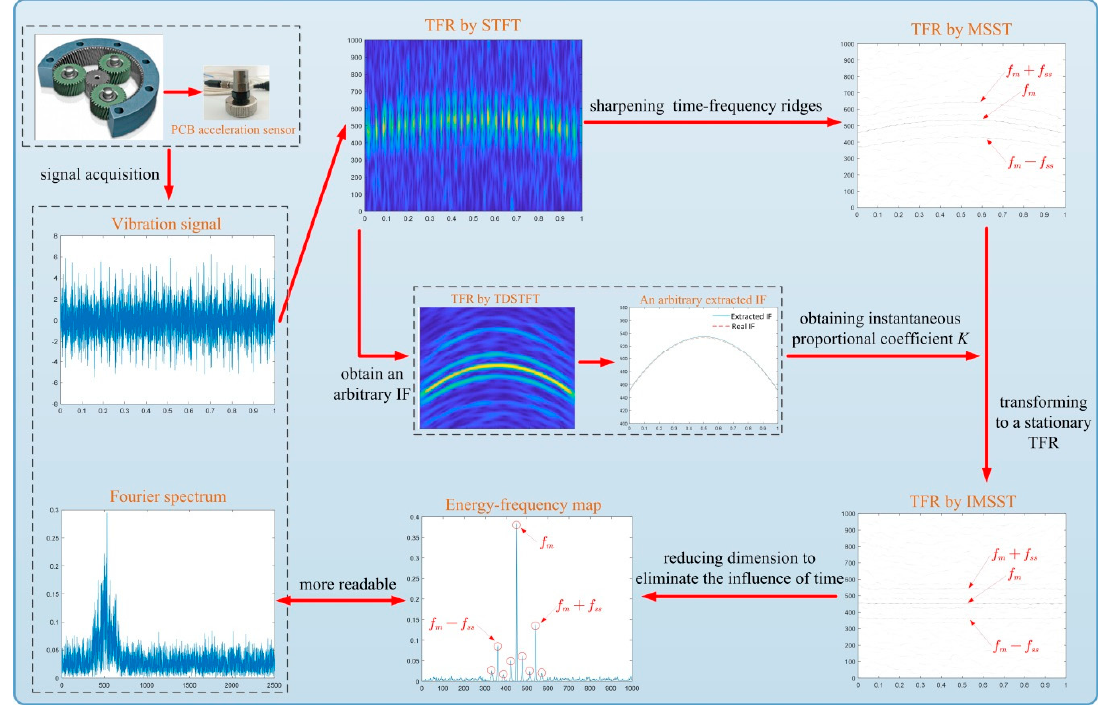
Figure 3. Flowchart of the proposed method.